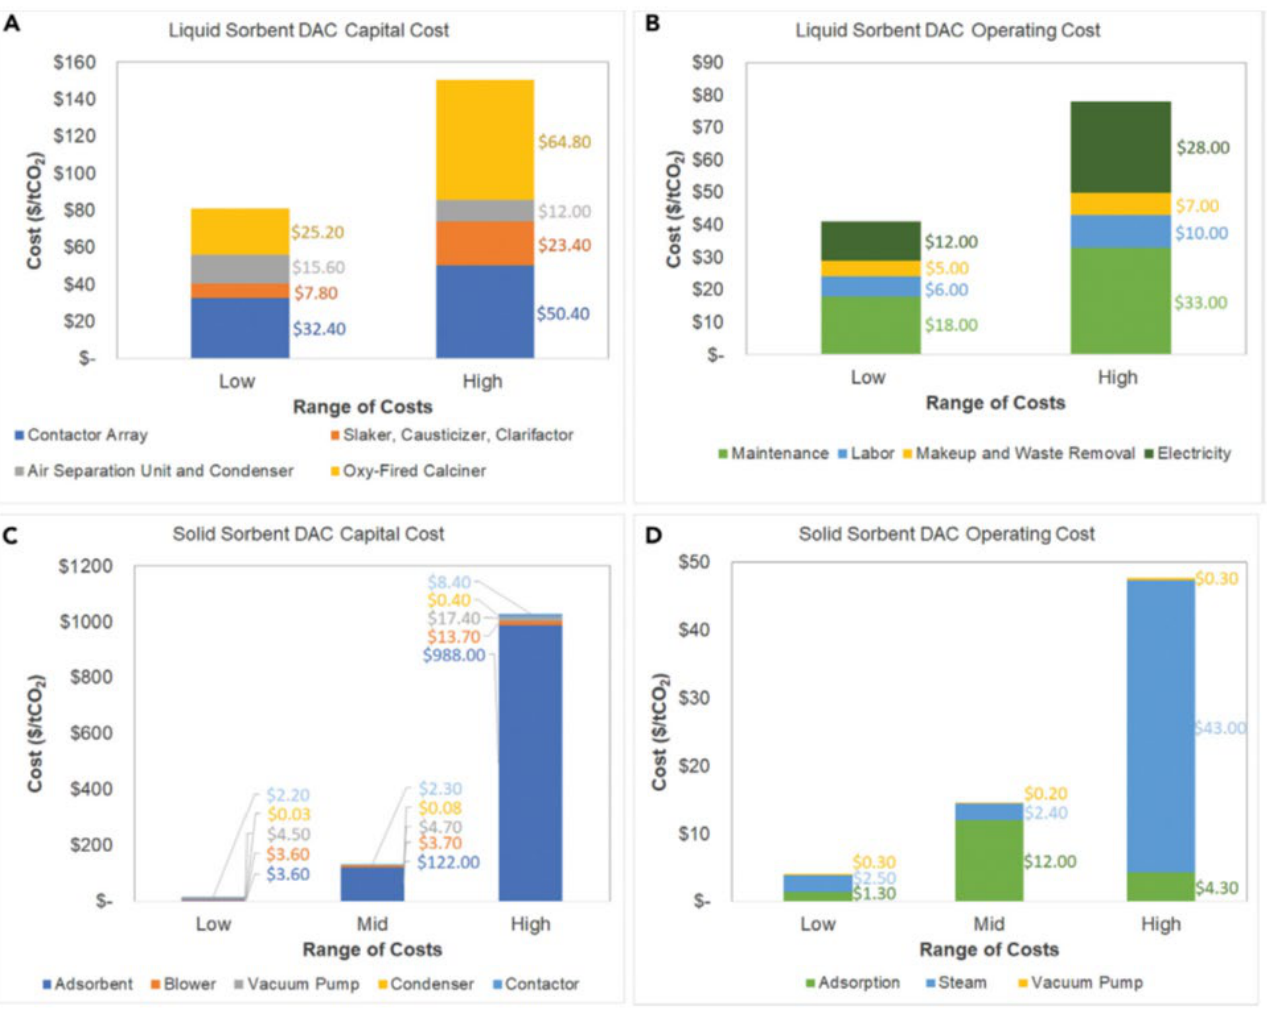
Figure 17. DAC cost breakdown and comparison: ( A ) liquid solvent SAC capital costs; ( B ) liquid solvent DAC operating costs; ( C ) solid sorbent DAC capital costs; ( D ) solid sorbent DAC operating costs. Reproduced with permission from [40] .